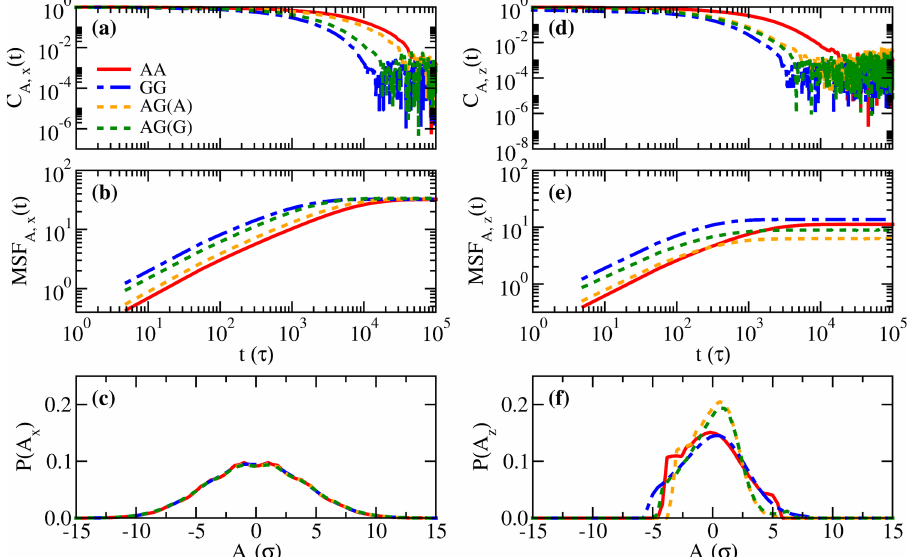
Figure 6. Comparisons of the normalized end-to-end fluctuation autocorrelation functions ( C A , α ( t ) ), the mean square displacements of the end-to-end fluctuation (MSF A , α ( t ) ), and the probability distri- bution functions of the end-to-end fluctuation ( P ( A α ) ) for systems AA, AG, and GG in the parallel direction, ( a – c ), and the perpendicular direction, ( d – f